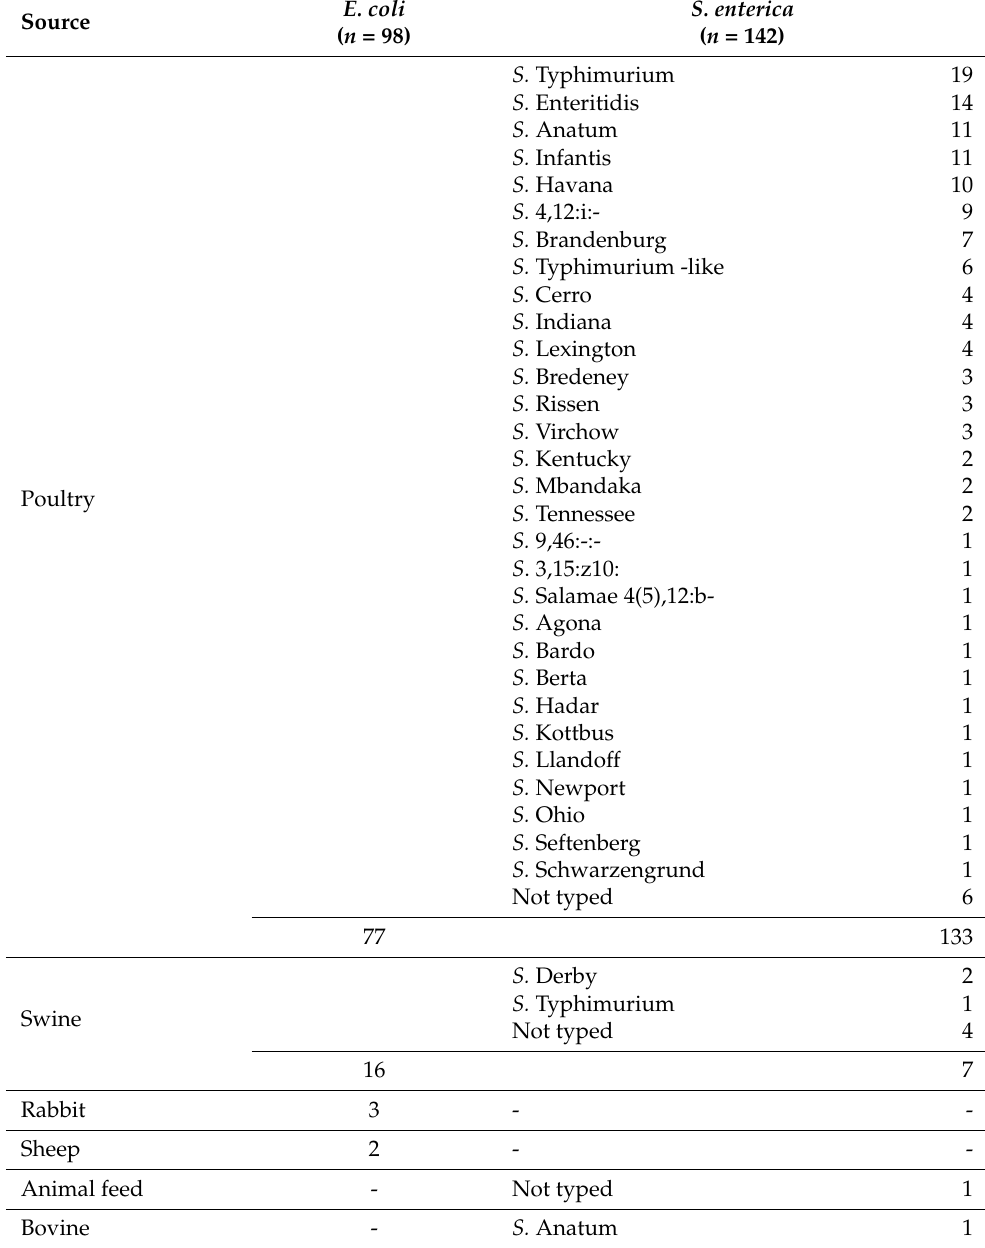
Table 1. Origin of Escherichia coli and serovar of Salmonella enterica isolates. The numbers at the end of table are the number of